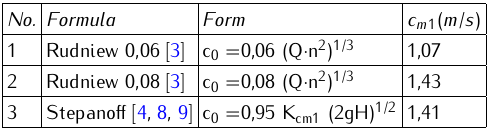
Table 2. The c m 1 velocity values with respect to calculation formulas.